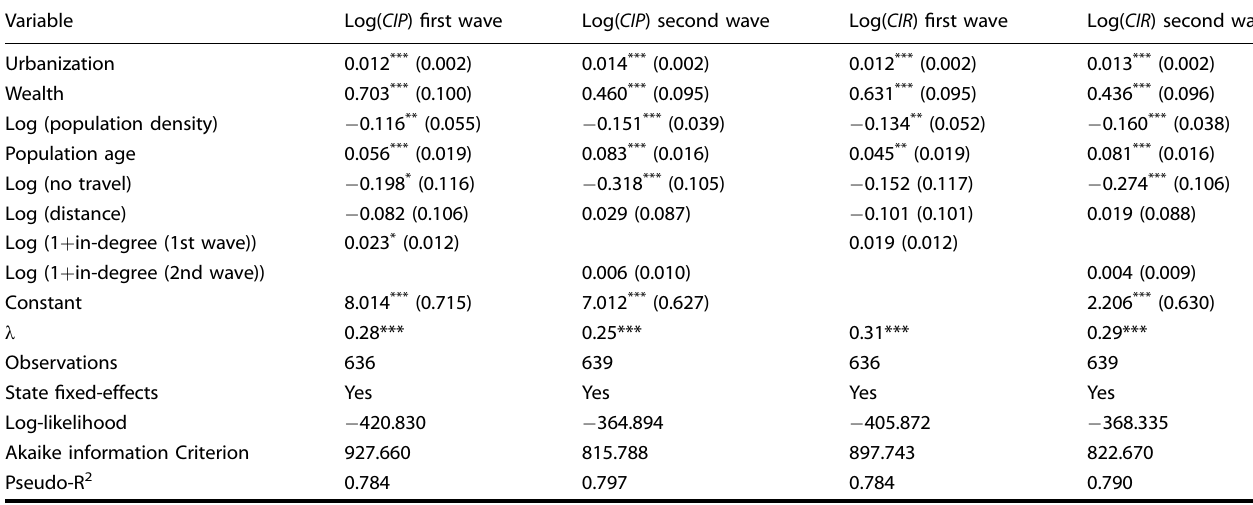
Table 2. Regression estimates of the effect size of varied spatial characteristics on cumulative incidence proportions ( CIP ) and incidence rates ( CIR ).